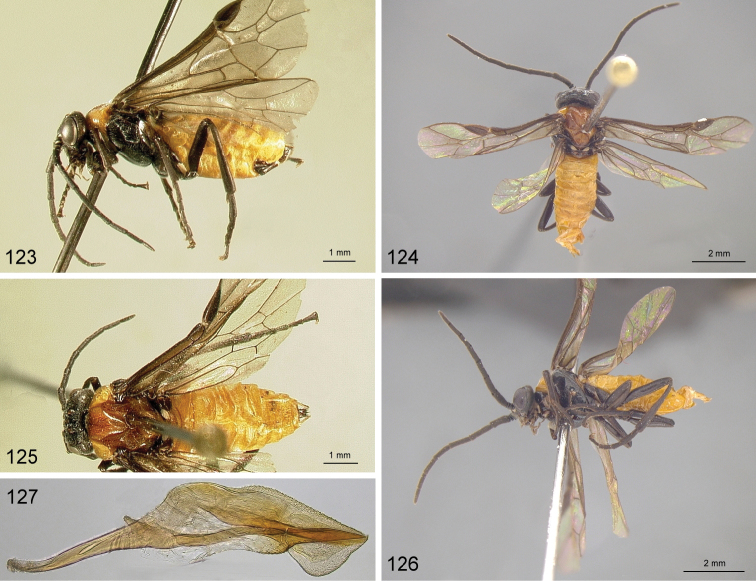
Nescianeura
noblecourti123, 125 ♀, holotype, France. 124, 126 ♂ DEI-GISHym20933, Germany 127 DEI-GISHym20933 penis valve. Scale bar 1 mm (123, 125), 2 mm (124, 126).